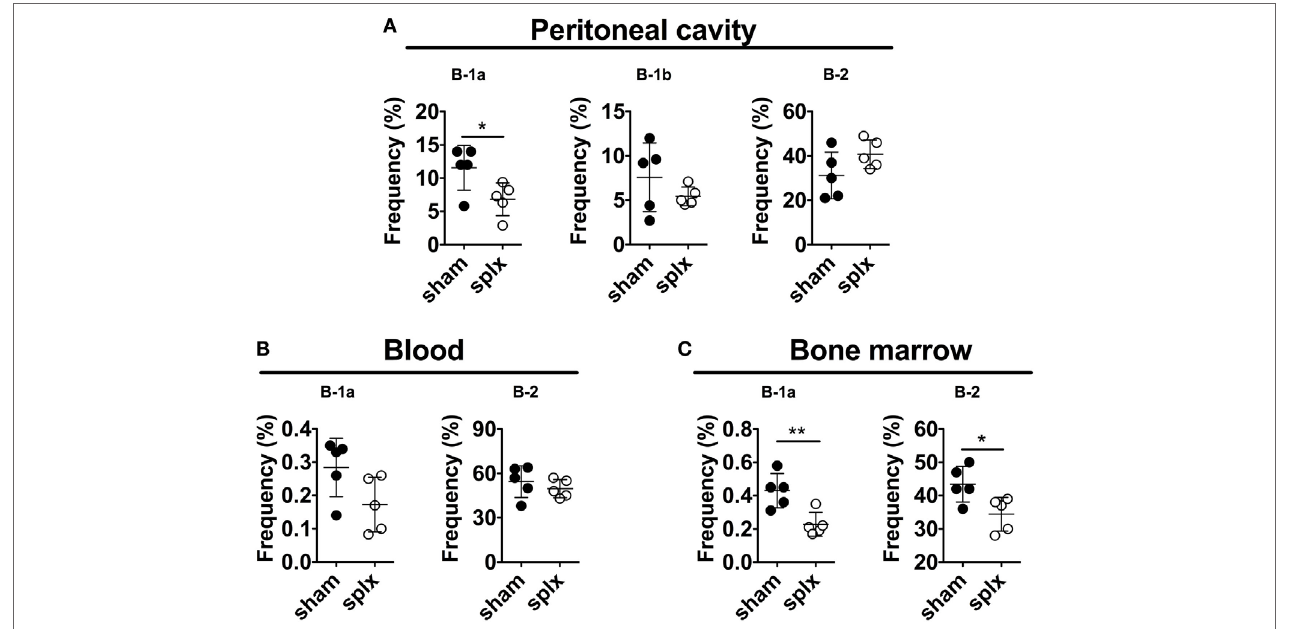
FigUre 2 | Splenectomy of adult mice leads to a decrease in B-1a cells. Adult 12-week-old wild-type mice were splenectomized or sham-operated and 10 days later stained for B-1 and B-2 cells (defined as in Figure 1 ) in (a) peritoneal cavity, (B) blood, and (c) bone marrow. The experiment was performed once and graphs display mean frequencies of the indicated cells in the lymphocyte gate ± SD. Statistically significant differences are indicated by * and **, denoting p < 0.05 and p < 0.01, respectively by unpaired t